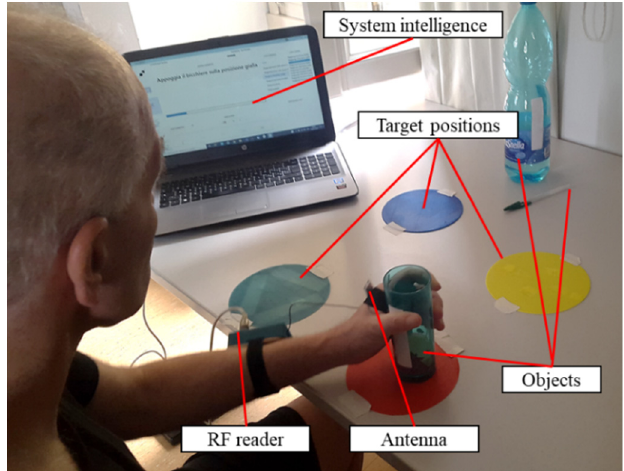
Figure 1. System worn by a patient during its usage. The patient wears the reader on his forearm and the antenna on his hand. The target positions and the objects are equipped with the tags and placed in the workspace. The system intelligence runs on a devoted PC.